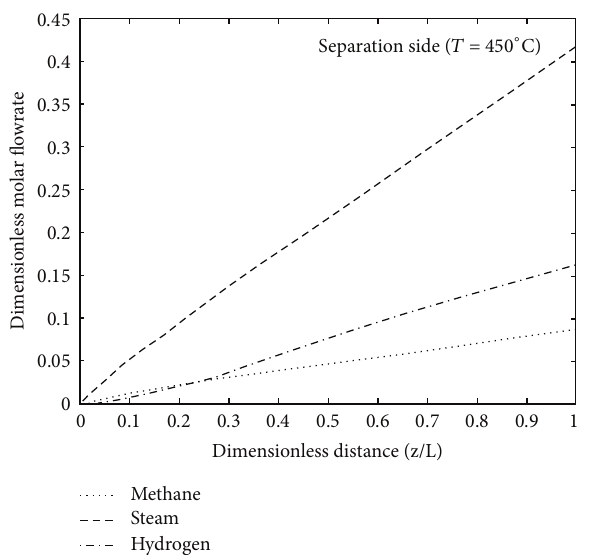
Figure 6: Modeling results of landfill gas-steam reformers for syngas production and SOFC continuous operation. Molar flowrate = 1.68 atm, feed composition: data in the separation side ( 𝑃 𝑇 𝑜 CH 4 :H 2 O:H 2 = 1:4 :0.20).